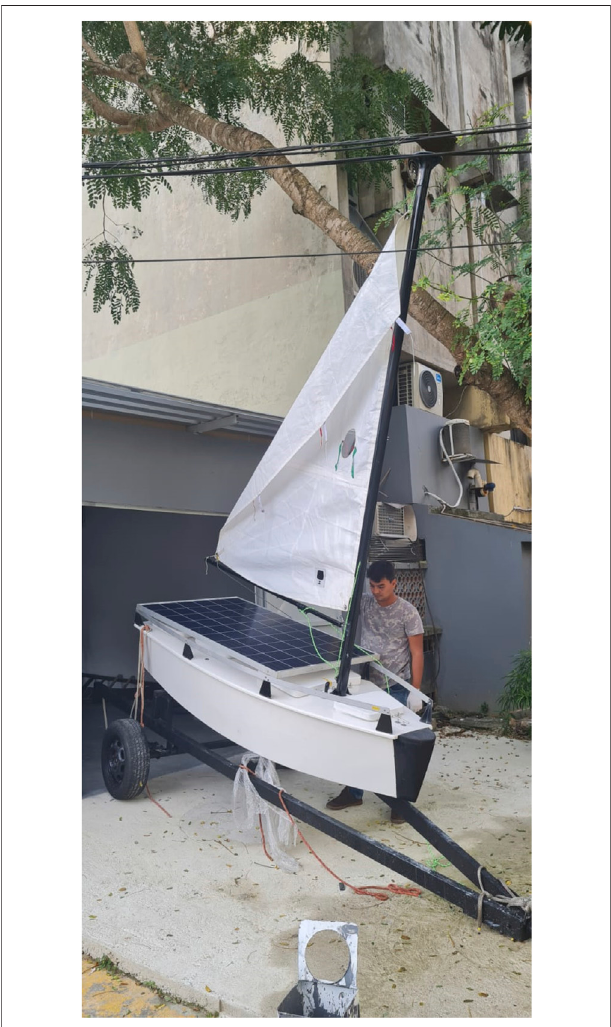
FIGURE 1 | F-Boat hull with its solar